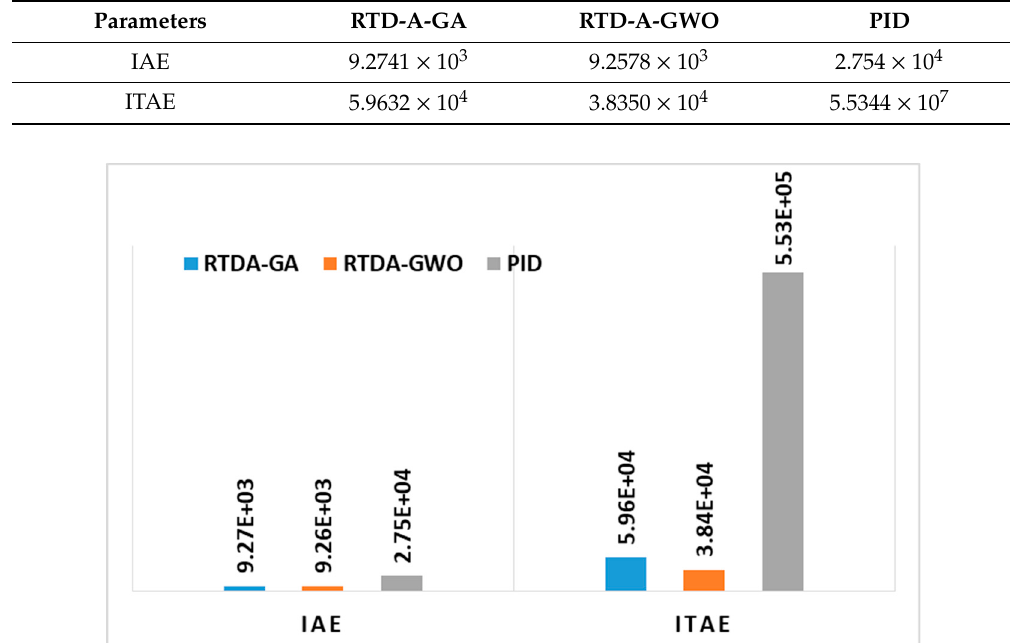
Figure 17. Case-2: Performance comparison chart between the gain scheduled RTD-A and PID.